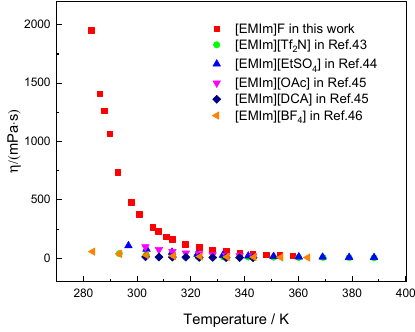
Figure 4. Viscosity of [EMIm]F and similar ILs as a function of temperature.